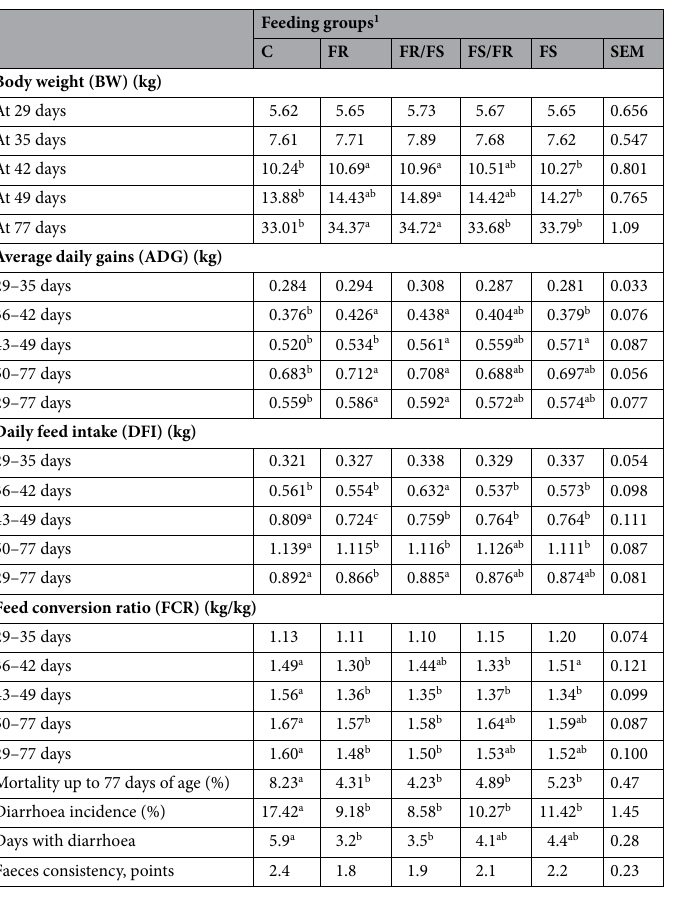
Table 2. Body weight, ADG, DFI, FCR, mortality, and diarrhoea incidence in piglets. a,b,c Values in rows marked with different letters differ significantly at p ≤ 0.05. 1 Feeding groups: C—control; FR—group receiving a diet with 8% FRSM; FR/FS—group receiving a diet with 6% FRSM and 2% FSBM; FS/FR—group receiving a diet with 6% FSBM and 2% FRSM; FS—group receiving a diet with 8%